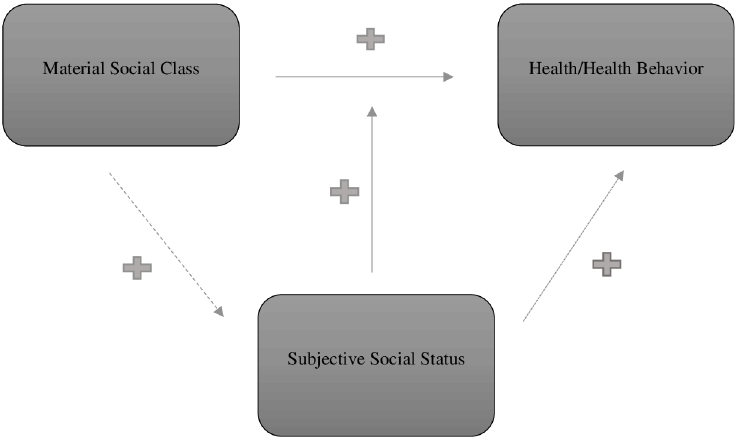
Fig 1. Conceptual model with the hypotheses regarding mediation and moderation.